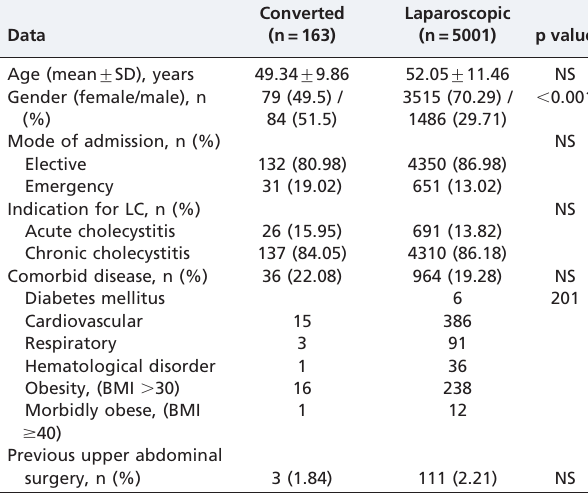
Table 1 - Characteristics of the patients in both groups.